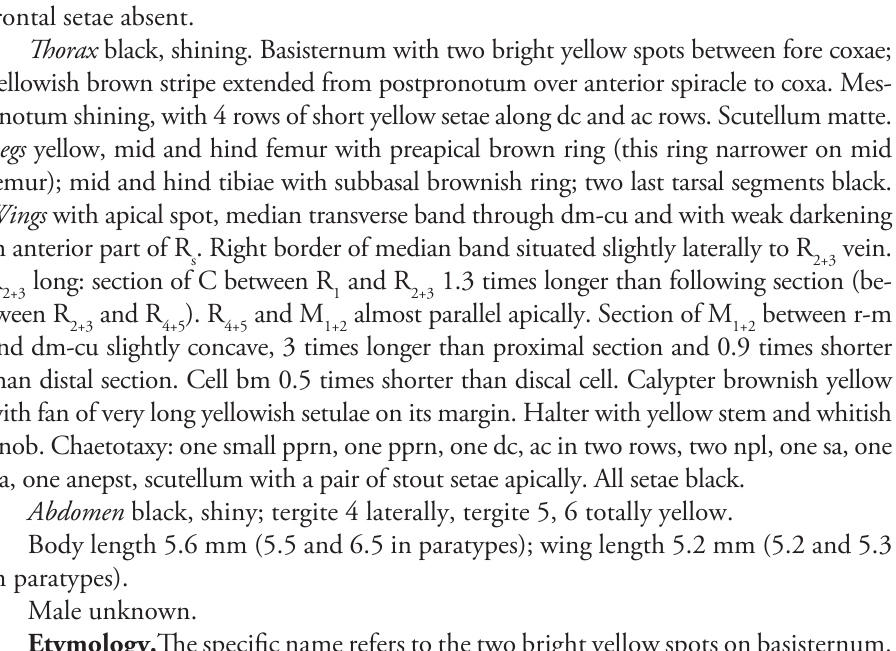
Type material. Holotype: 1 female, Vietnam, Lai Châu Province, Hoáng Liên (22.33788°N, 103.77922°E), 2068 m, 7.V. 2013 (T.V. Galinskaya). ZMUM. Diagnosis. This new species belongs to the S. crinita species group. Species of this group are characterized by transparent wing, bare arista, yellow legs, mid and hind femora with apical dark brown ring. Within this group the new species is close to spe- cies with yellow face and totally black frons. The new species differ from all species of S. crinita species group by palpus with character coloration (yellow, darkened in basal half on anterior margin, with some black setulae apically). Among oriental species only S. stylocera from Philippines has these characters, but it is a much smaller species, 2.7 mm (4.8 mm in S. dichroa